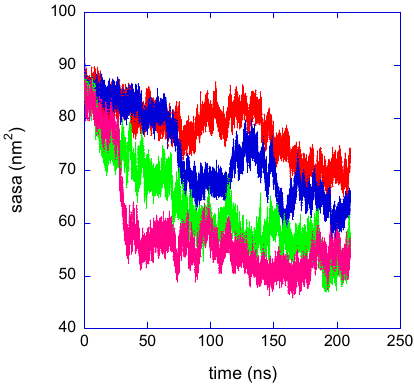
Figure 4. Time behaviour of the solvent surface accessible area of the two-chain ensemble. Red and blue curves refer to atactic and isotactic-rich PNIPAM, respectively, at T = 283 K. Green and pink curves refer to atactic and isotactic-rich PNIPAM, respectively, at T = 323 K.